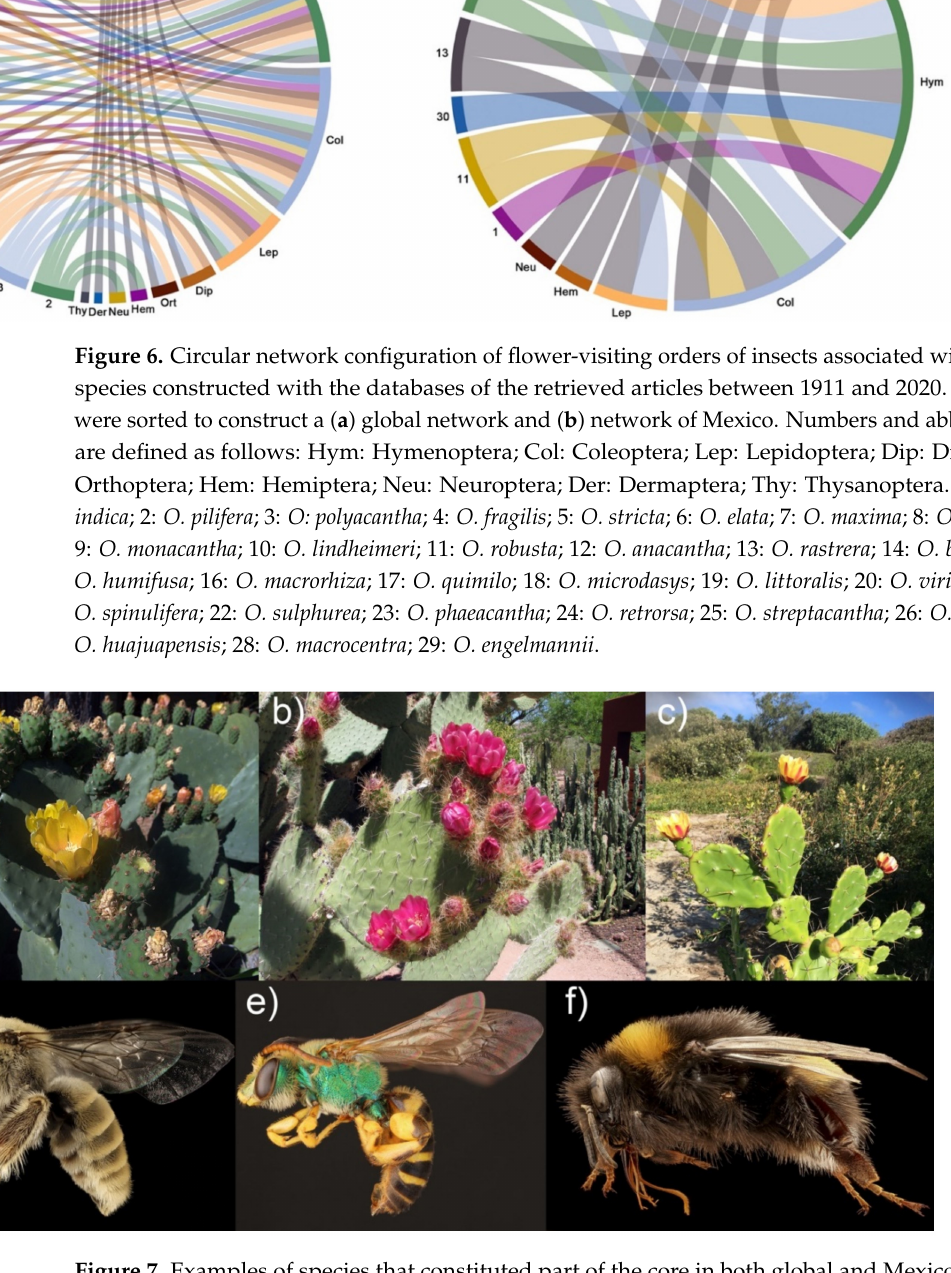
Figure 7. Examples of species that constituted part of the core in both global and Mexico networks. Upper figures show the flowering Opuntia species ( a ) O. ficus-indica , ( b ) O. pilifera , and ( c ) O. monacan- tha and lower figures show core bees ( d ) Diadasia rinconis , ( e ) Agapostemon texanus , and ( f ) Bombus terrestris . Note that the photos are not